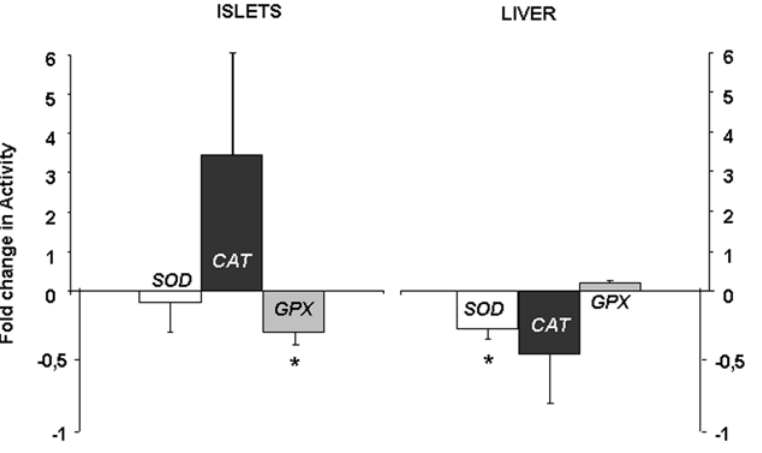
Figure 3. Effect of low protein diet on fetal pancreatic islets and liver antioxidant enzyme activity, SOD (white bars), CAT (black bars), GPX (grey bars). Data are expressed as fold change in activity relative to C; n=5–6 independent experiments. *p , 0.05 vs controls.